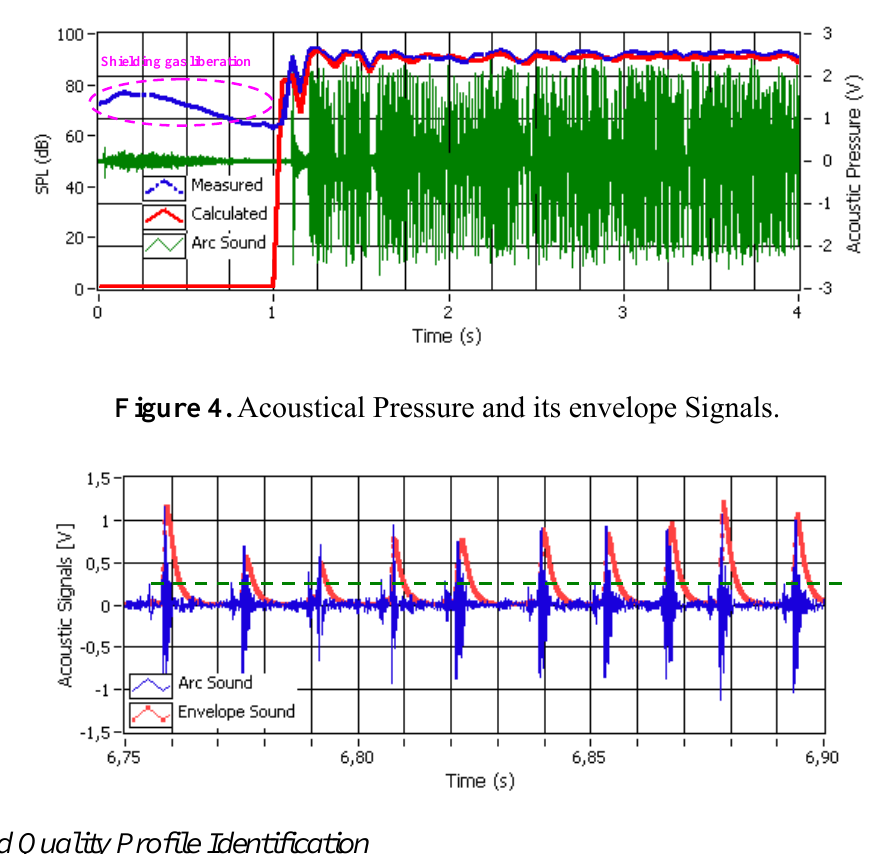
Figure 3. Measured and Calculated SPL.